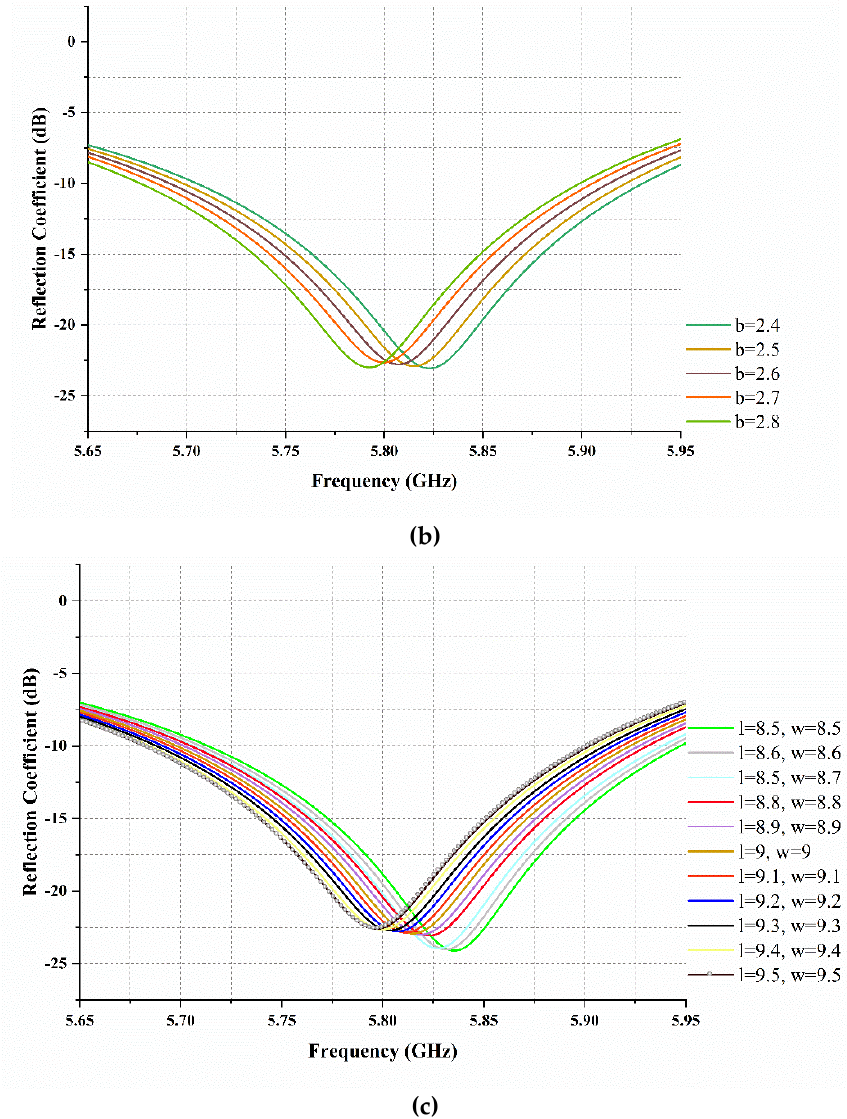
Figure 8. Reflection coefficient variation with respect to ES radii: ( a ) Radius a ; ( b ) Radius b ; ( c ) RDR dimensions variations.